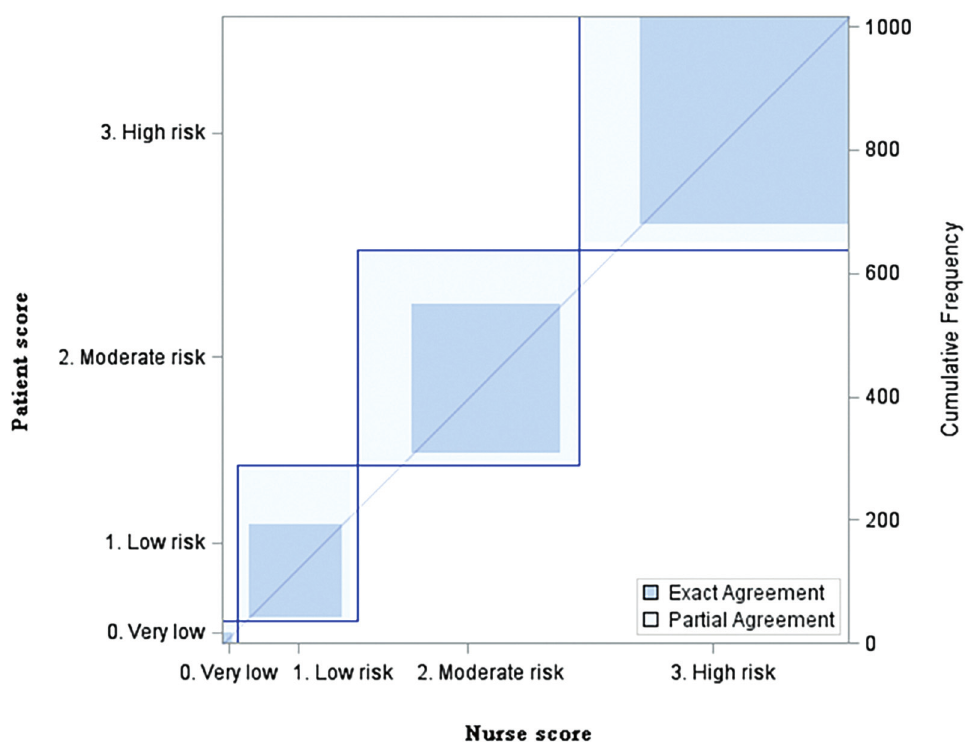
Fig. 1 Agreement level in risk strati fi cation between nurse-completed and patient-completed forms ( n ¼ 1017). The fi gure indicated that the risk strati fi cation of patient self-evaluation and nurse-completed evaluation was